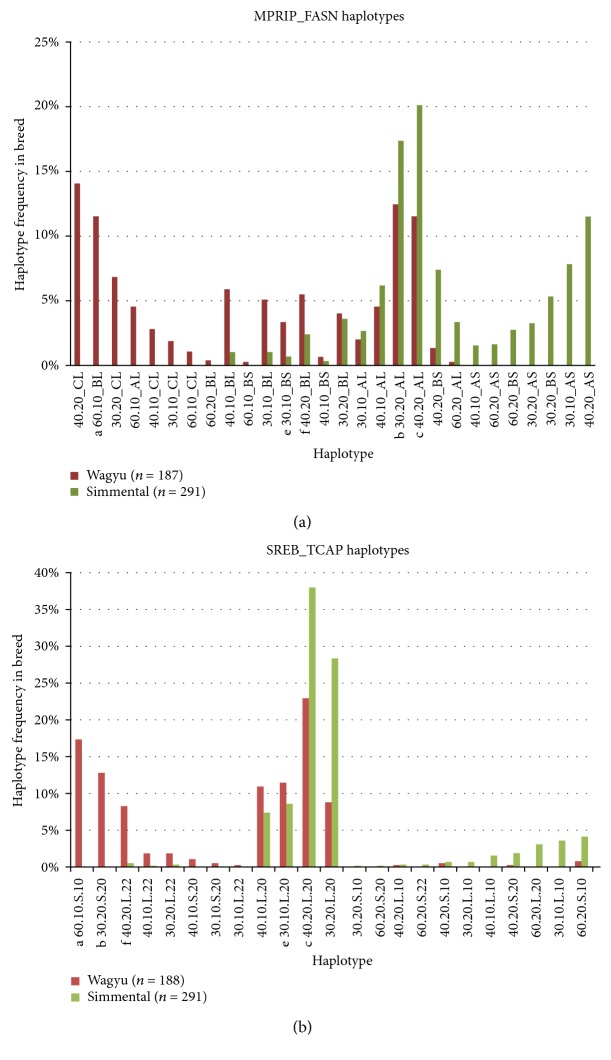
W plot comparing haplotype frequencies in Wagyu and Simmental. Adapted from [58]. (a) The haplotypes are from MPRIP to FASN (see Figure 2). Note SCT-FSN L in Wagyu and S in Simmental, also GH C in Wagyu and GH A in Simmental with GH B largely in the haplotypes common to both breeds. Haplotype designation is MPRIP.TCAP_GH SCT-FSN. (b) Haplotypes are from SREBF1 to TCAP. Haplotype designation is MPRIP.TCAP.SREB.NT5M. The four most common haplotypes of Simmental are also found at high frequency in Wagyu (and many other breeds not shown here), while two of the three most common haplotypes of Wagyu are not found in Simmental (and are not common in any other breed tested).